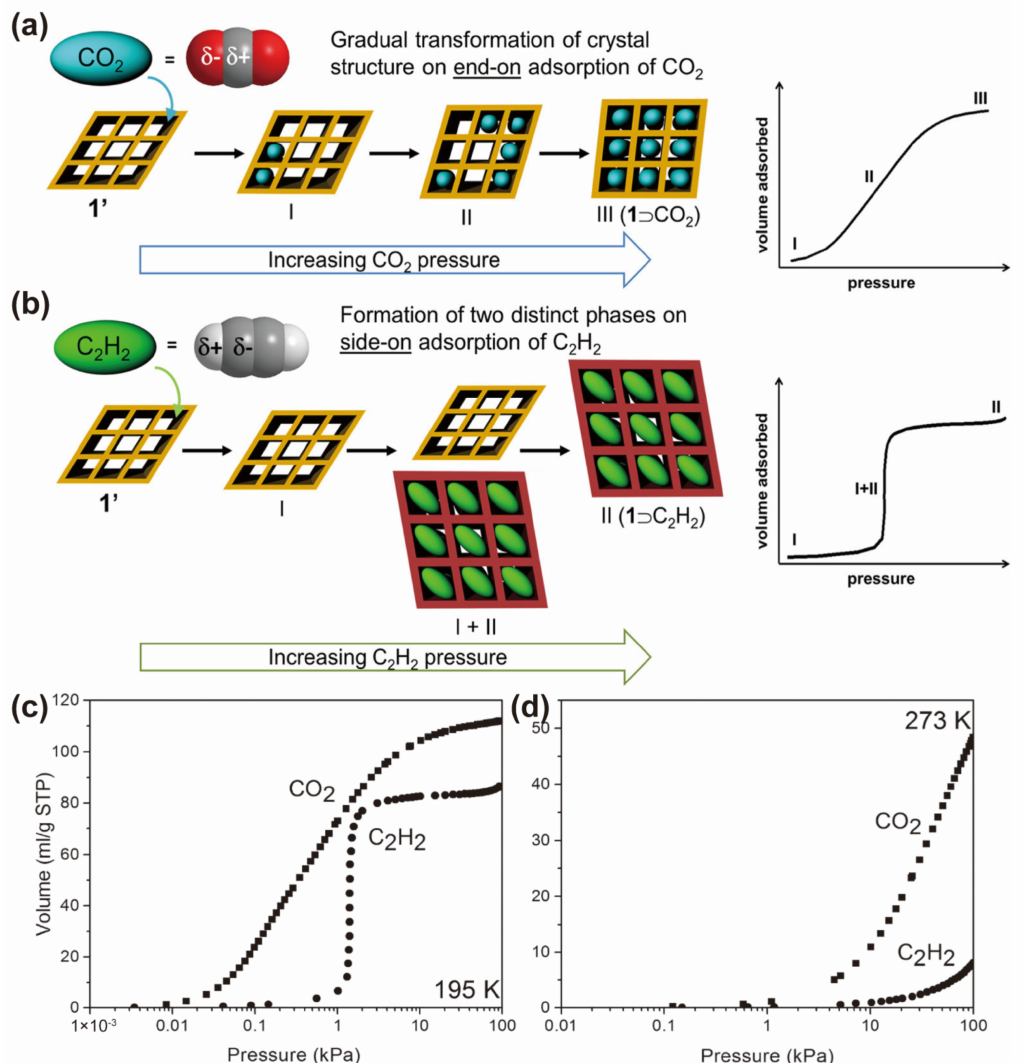
Figure 6. ( a , b ) Potential adsorption mechanism of [Mn(bdc)(dpe)] for CO 2 ( a ) and C 2 H 2 ( b ) at 195 K. ( c , d ) Adsorption isotherms of [Mn(bdc)(dpe)] for CO 2 and C 2 H 2 at 195 ( c ) and 273 K ( d ). Reproduced with permission from Foo et al., Journal of the American Chemical Society; published by American Chemical Society, 2016